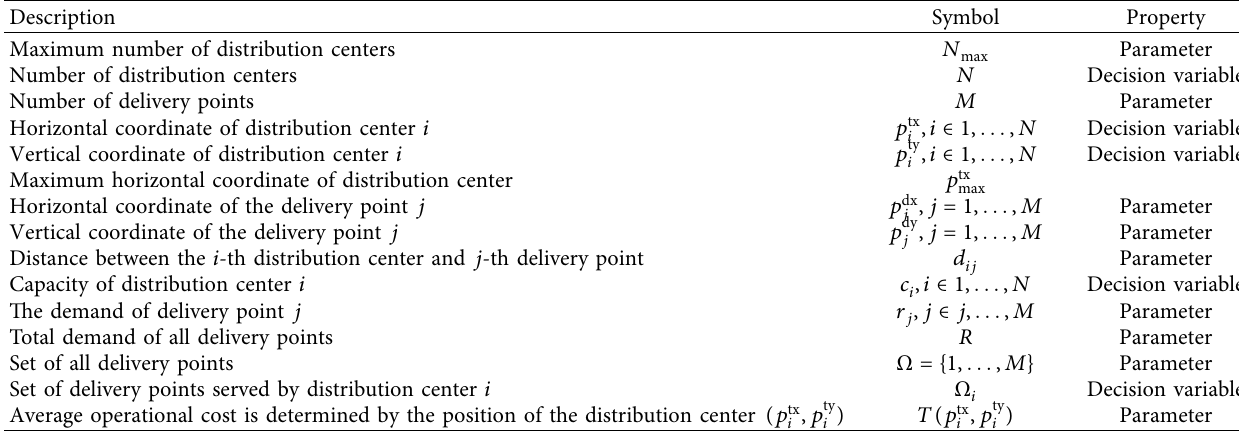
Table 1: Symbols and